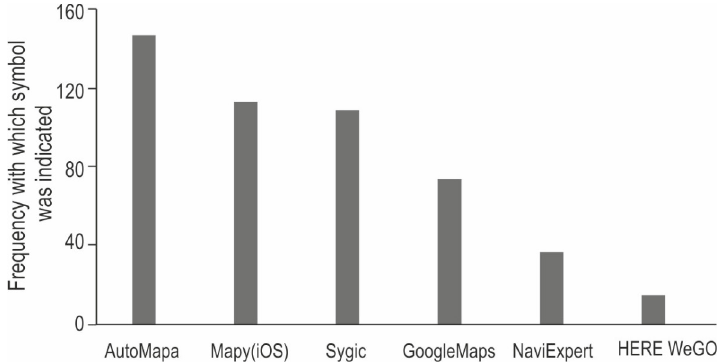
Fig. 6. Frequency of a symbol from a given application being indicated as most associated with the intended